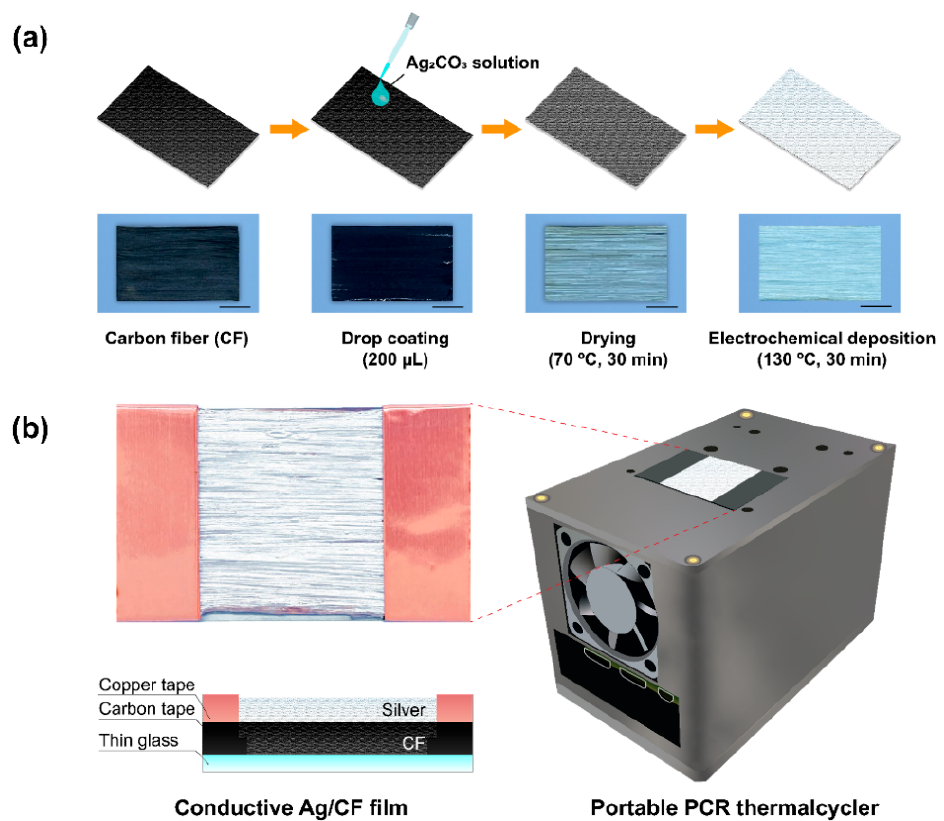
Figure 1. Schematic of Ag/CF film-based portable thermal cycler: ( a ) the fabrication process of Ag/CF film; ( b ) schematic drawing of the thermal cycler and cross-sectional view of the fabricated Ag/CF film. The scale bar is 10 mm.